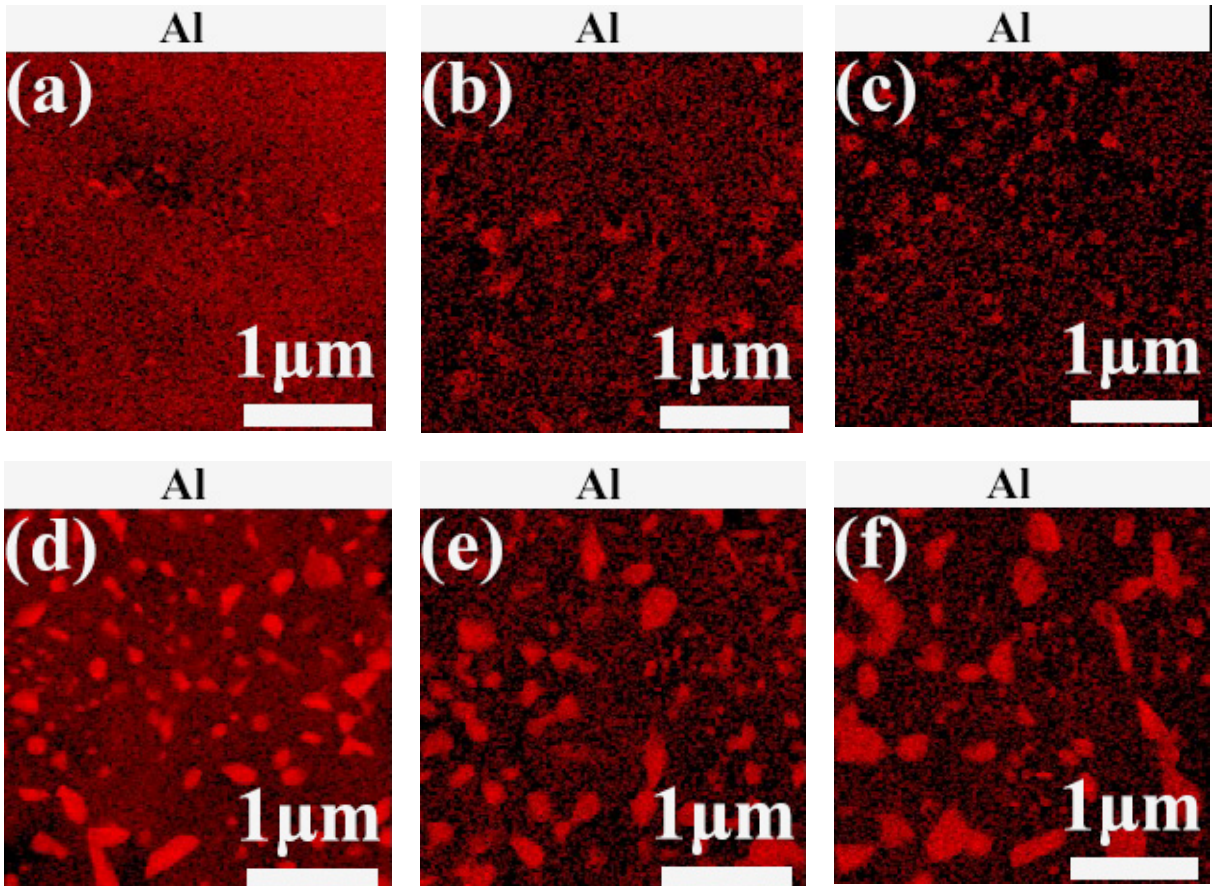
Figure 5. TEM images and corresponding SADP of B2 phase in 90% rolled and annealed samples: ( a ) AR500 sample; ( b ) AR540 sample; ( c ) AR590 sample; ( d ) AR660 sample; ( e ) AR700 sample; ( f ) AR800 sample; ( g , h ) SADP of B2 phase and matrix in AR660 sample.